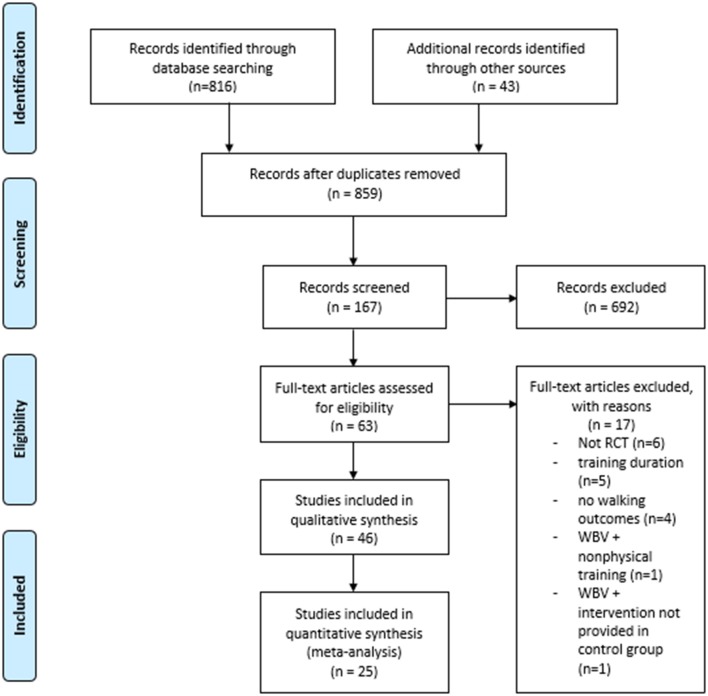
PRISMA flow chart of study selection process.